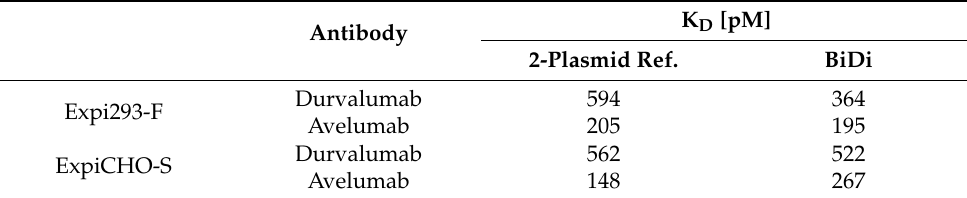
Table 1. Affinity determination of Avelumab and Durvalumab using either co-transfection or 2xeCMV BiDi plasmid. K D [pM] Antibody 2-Plasmid Ref. BiDi Expi293-F